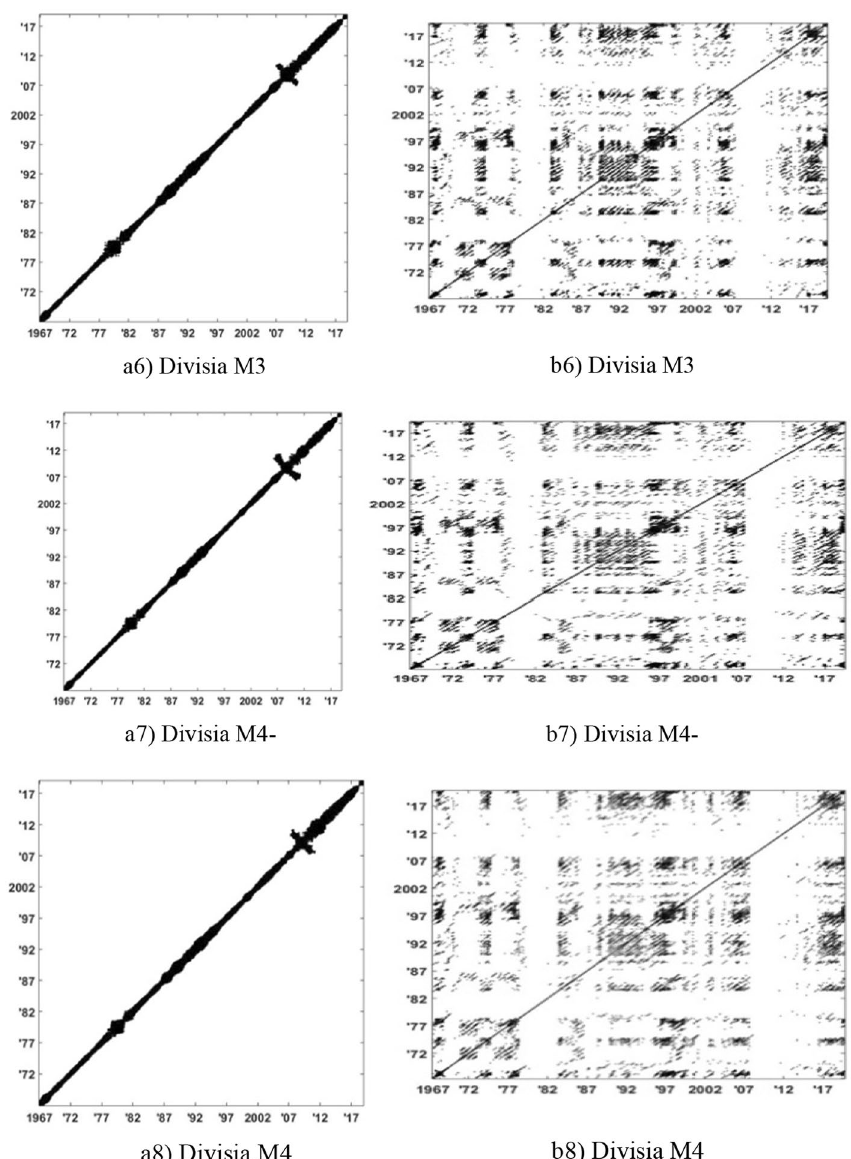
Fig. 4 RPs of broad Divisia monetary aggregates: Logarithmic values in Panel ( a ) and growth rates in